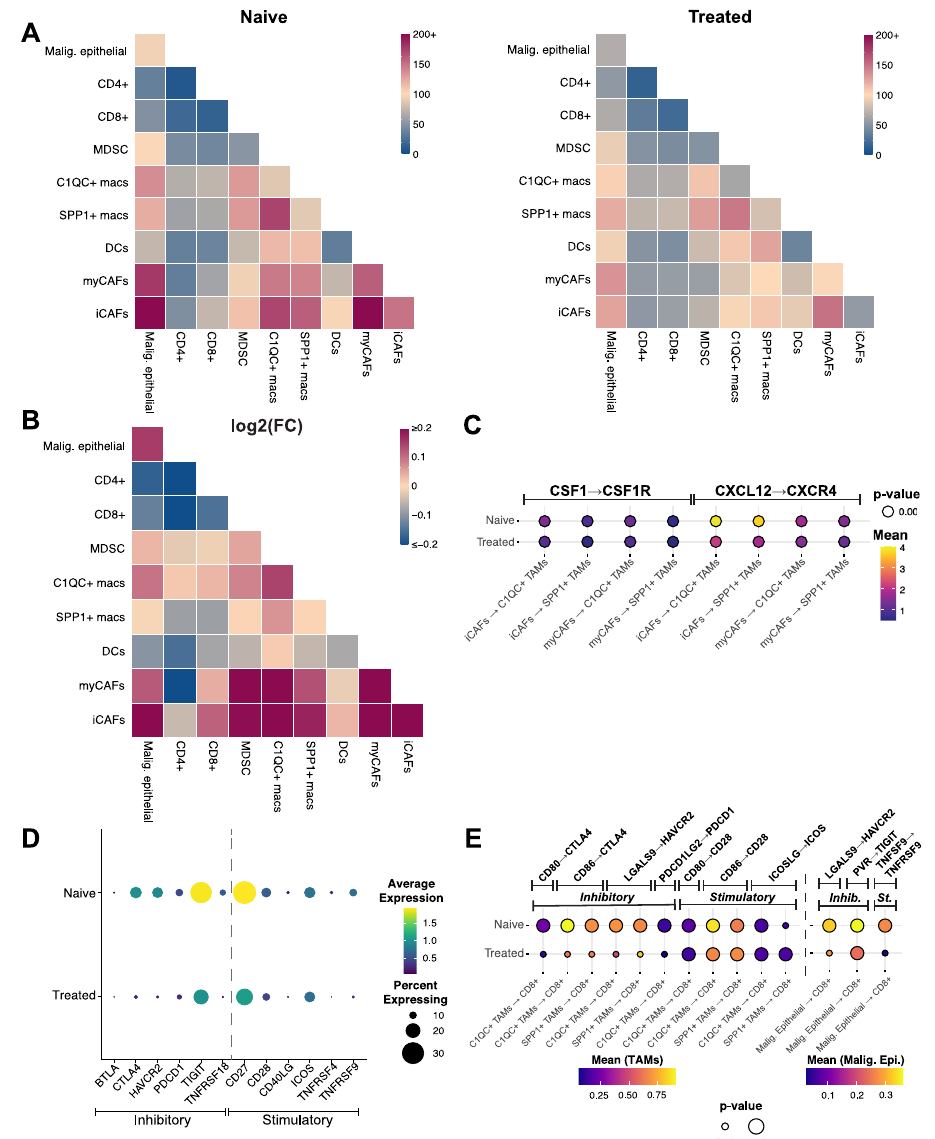
Fig. 7 | Chemotherapy reduces expression of inhibitory checkpoint molecules and ligand-receptor interactions in PDAC. A Heatmap displaying an overview of all inferred LRIs between displayed cell types (cancer cells, MDSCs, DCs, C1QC + TAMs, SPP 1 +TAMs, iCAFs, myCAFs, CD8 +T cells, CD4 +T cells). Left: untreated samples,right:treatedsamples.CAFcancer-associated fi broblast,DCdendriticcell, iCAF in fl ammatory CAF, LRI ligand-receptor interaction, MDSC myeloid-derived suppressor cell, myCAF myo fi broblastic CAF, TAM tumor-associated macrophage. B HeatmapdisplayingthefoldchangebetweenthenumberofinferredLRIsinnaïve